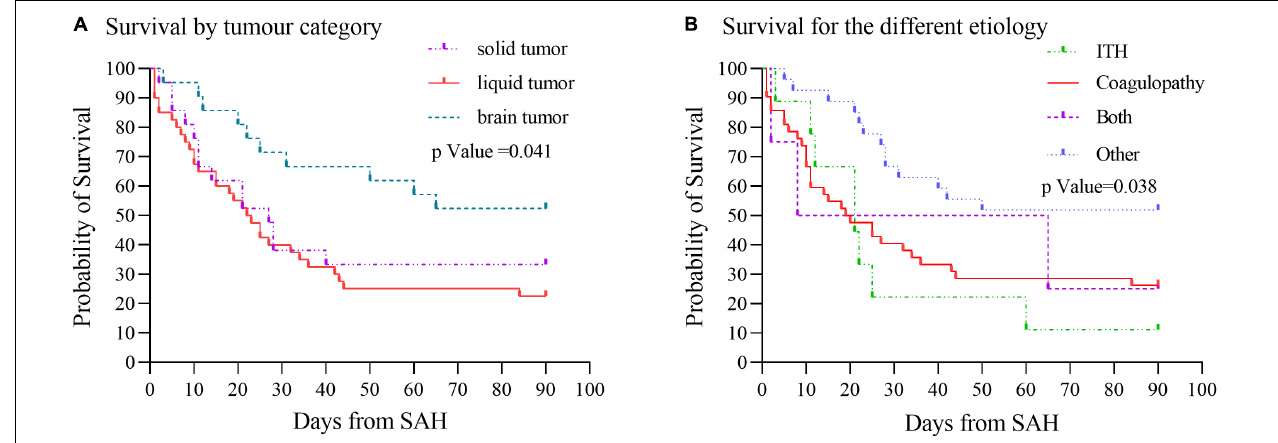
FIGURE 5 | Survival curves by cancer type and etiology of SAH. (A) Cancers were categorized as solid, liquid, or brain tumor. Kaplan–Meier curves showed survival time of cancer patients with SAH differed ( p = 0.041) by cancer type. (B) Etiology of SAH was grouped as intratumoral hemorrhage, coagulopathy, both intratumoral hemorrhage and coagulopathy, or other diagnoses. Survival analysis based on the etiology of SAH showed survival time difference ( p = 0.038). ITH, intratumoral hemorrhage.